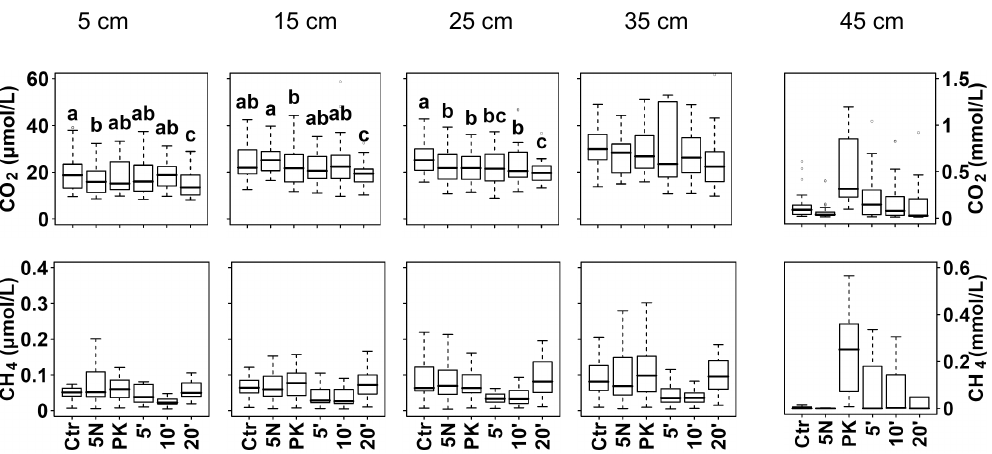
Fig. 5. Box-whisker-plots for CO 2 and CH 4 concentrations with increasing fertilization degree for shallower depths. Treatments with no letters in common are significantly different at p < 0 . 1 (t-test). Due to non-normality of the CH 4 and CO 2 concentrations in deeper depths, a t-test was not applied to these